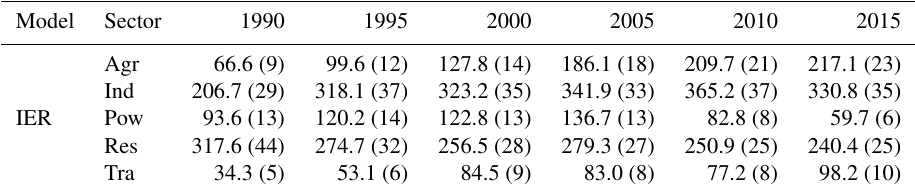
Table 4. PM 2 . 5 -related premature mortality contributed by the agricultural (Agr), industrial (Ind), power (Pow), residential (Res) and trans- portation (Tra) sectors. Estimated with IER risk function [unit: thousand